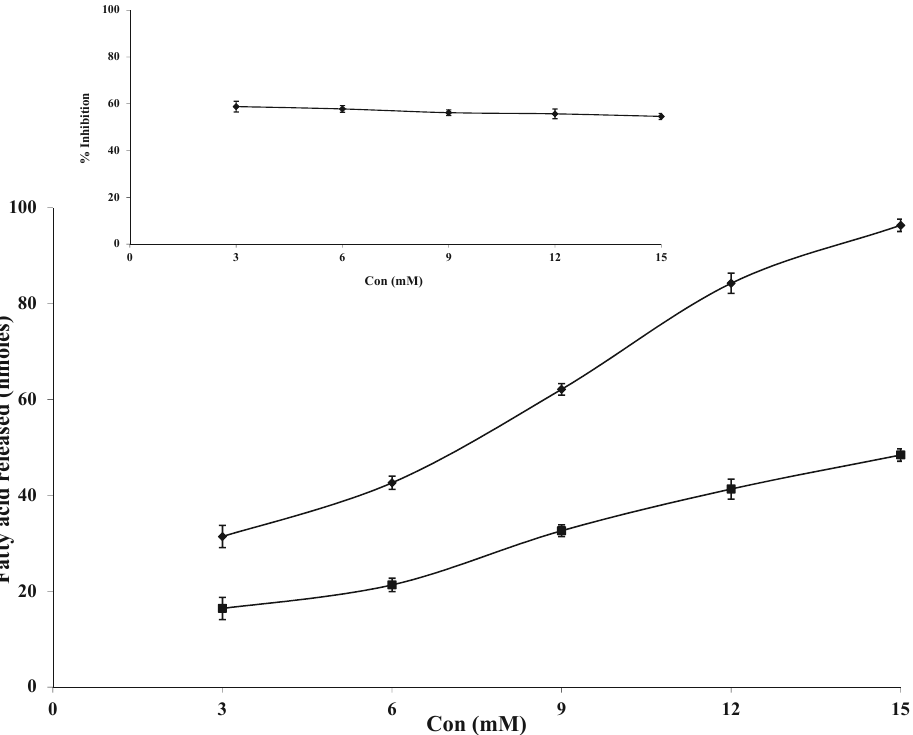
by aqueous 2 (6 μ gs) was 2